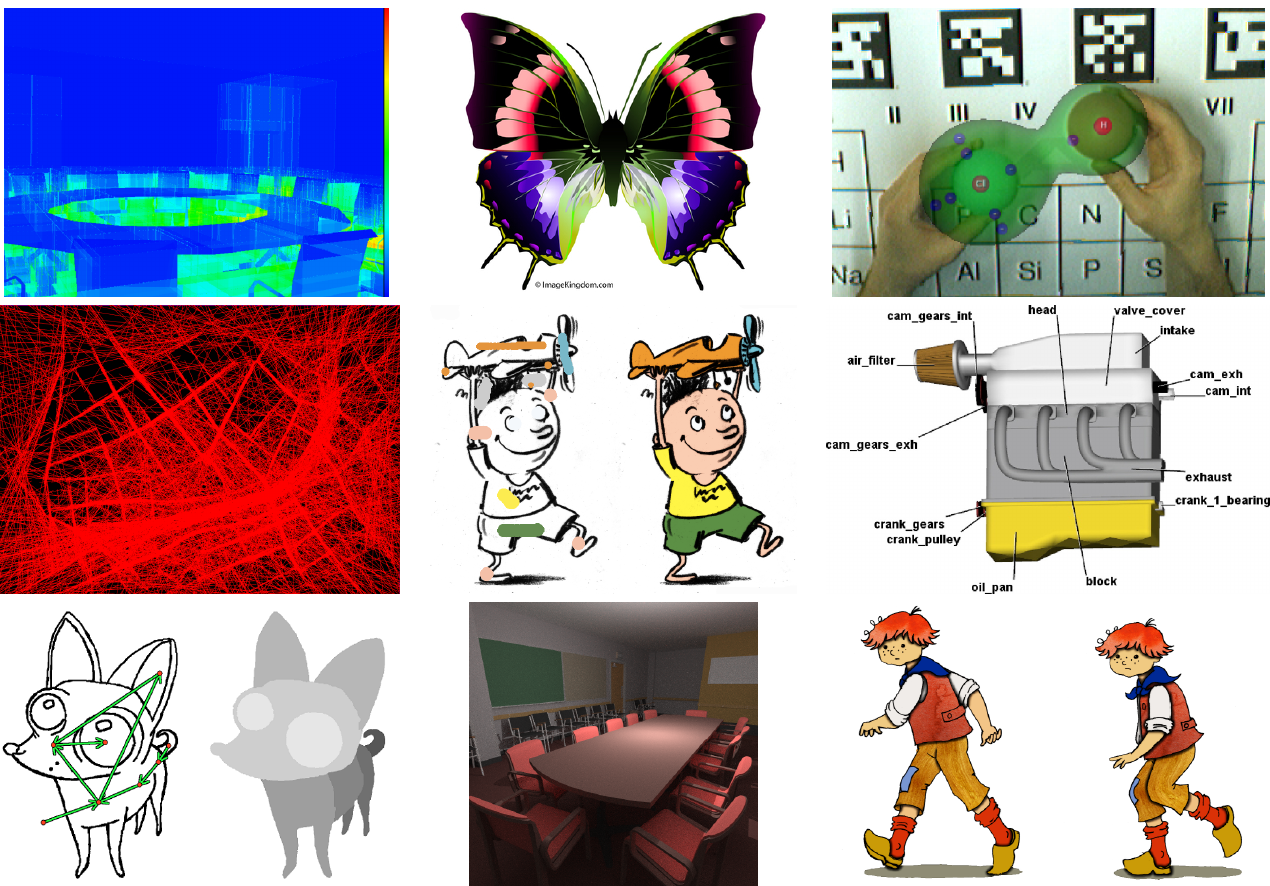
Fig. 2. Images illustrating some of the results of our recent research projects (all images are a courtesy of the authors of the corresponding papers). (top) Ray Tracing with Sparse Boxes [8], Perceptual Evaluation of Color-to-Grayscale Image Conversions [4], Real-time Color Ball Tracking for Augmented Reality [22]. (middle) Adaptive Global Visibility Sampling [2], LazyBrush: Flexible Painting Tool for Hand-drawn Cartoons [23], Layout-aware optimization for interactive labeling of 3D models, (bottom) Adding Depth to Cartoons Using Sparse Depth (In)equalities [13], Efficient Stack-less Traversal Algorithm for Ray Tracing with BVH [9] (the depicted model is a courtesy of Anat Grynberg and Greg Ward), TexToons: Practical Texture Mapping for Hand-drawn Cartoon Animations